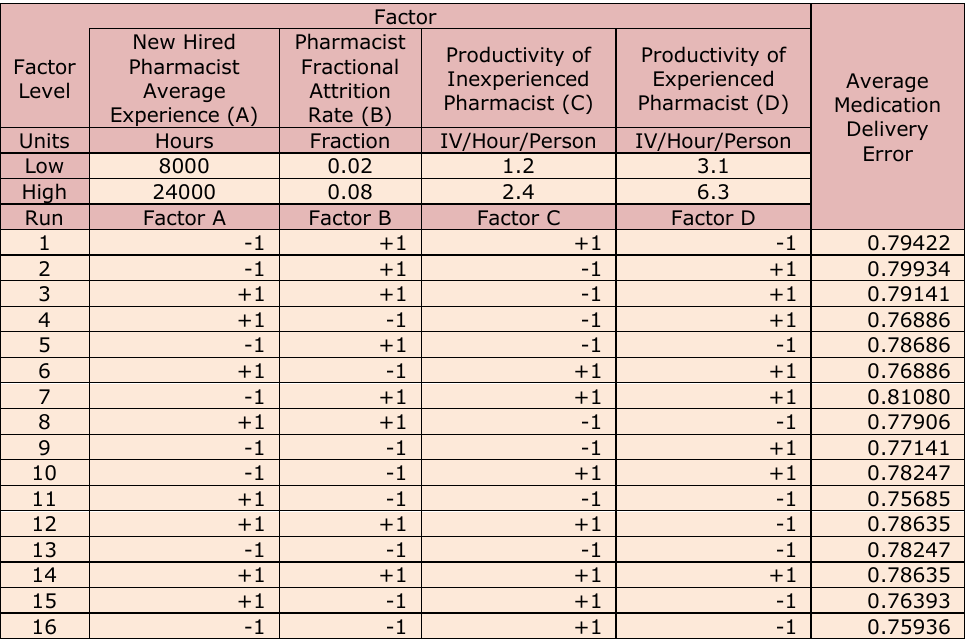
Figure 7. Medication Delivery Error